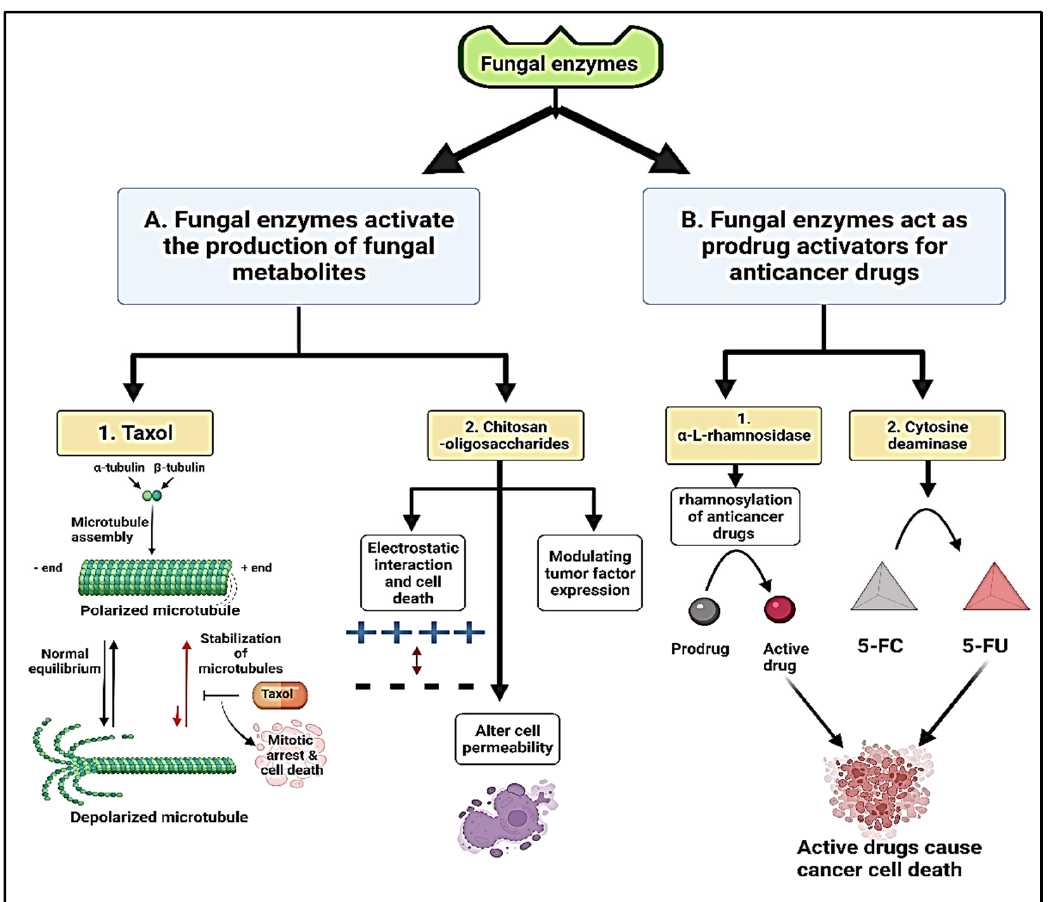
Figure 5. Schematic illustration represents the mechanism of anticancer effect of the fungal enzymes, 5-fluorocytosine (5-FC), and 5-fluorouracil (5-FU).